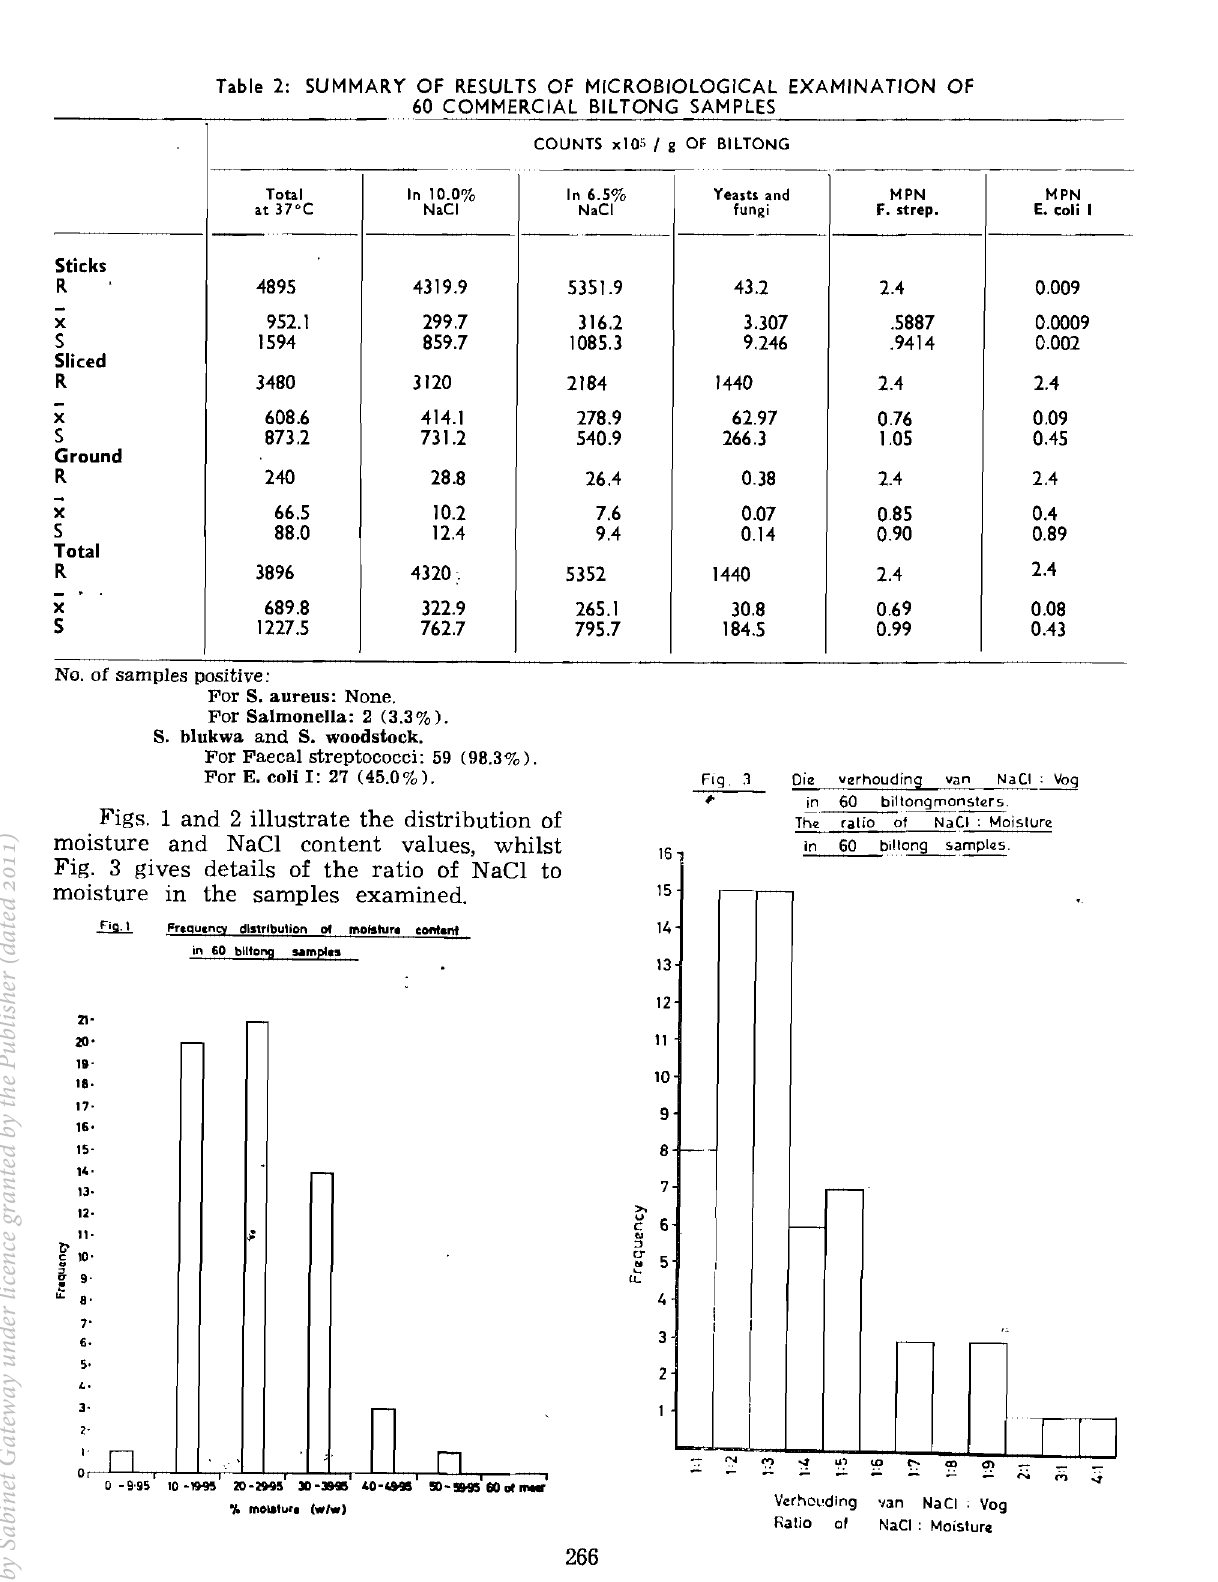
Table 2: SUMMARY OF RESULTS OF MICROBIOLOGICAL EXAMINATION OF 60 COMMERCIAL BILTONG